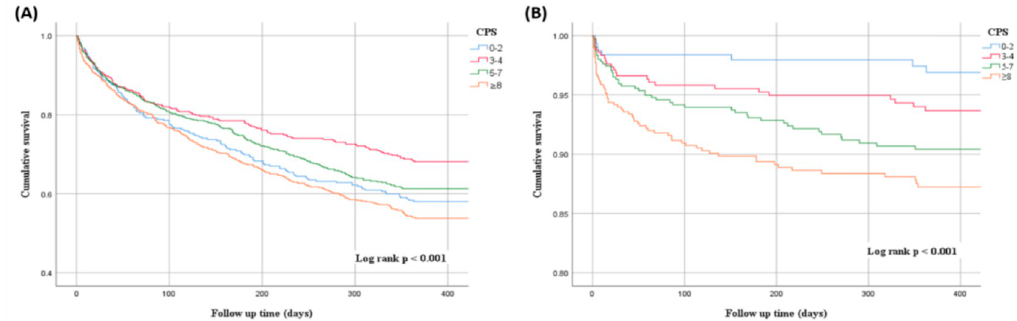
Fig 2. Cumulative 1–year survival between different carotid plaque score (CPS) groups. (A) all–cause mortality (B) CV– related mortality.